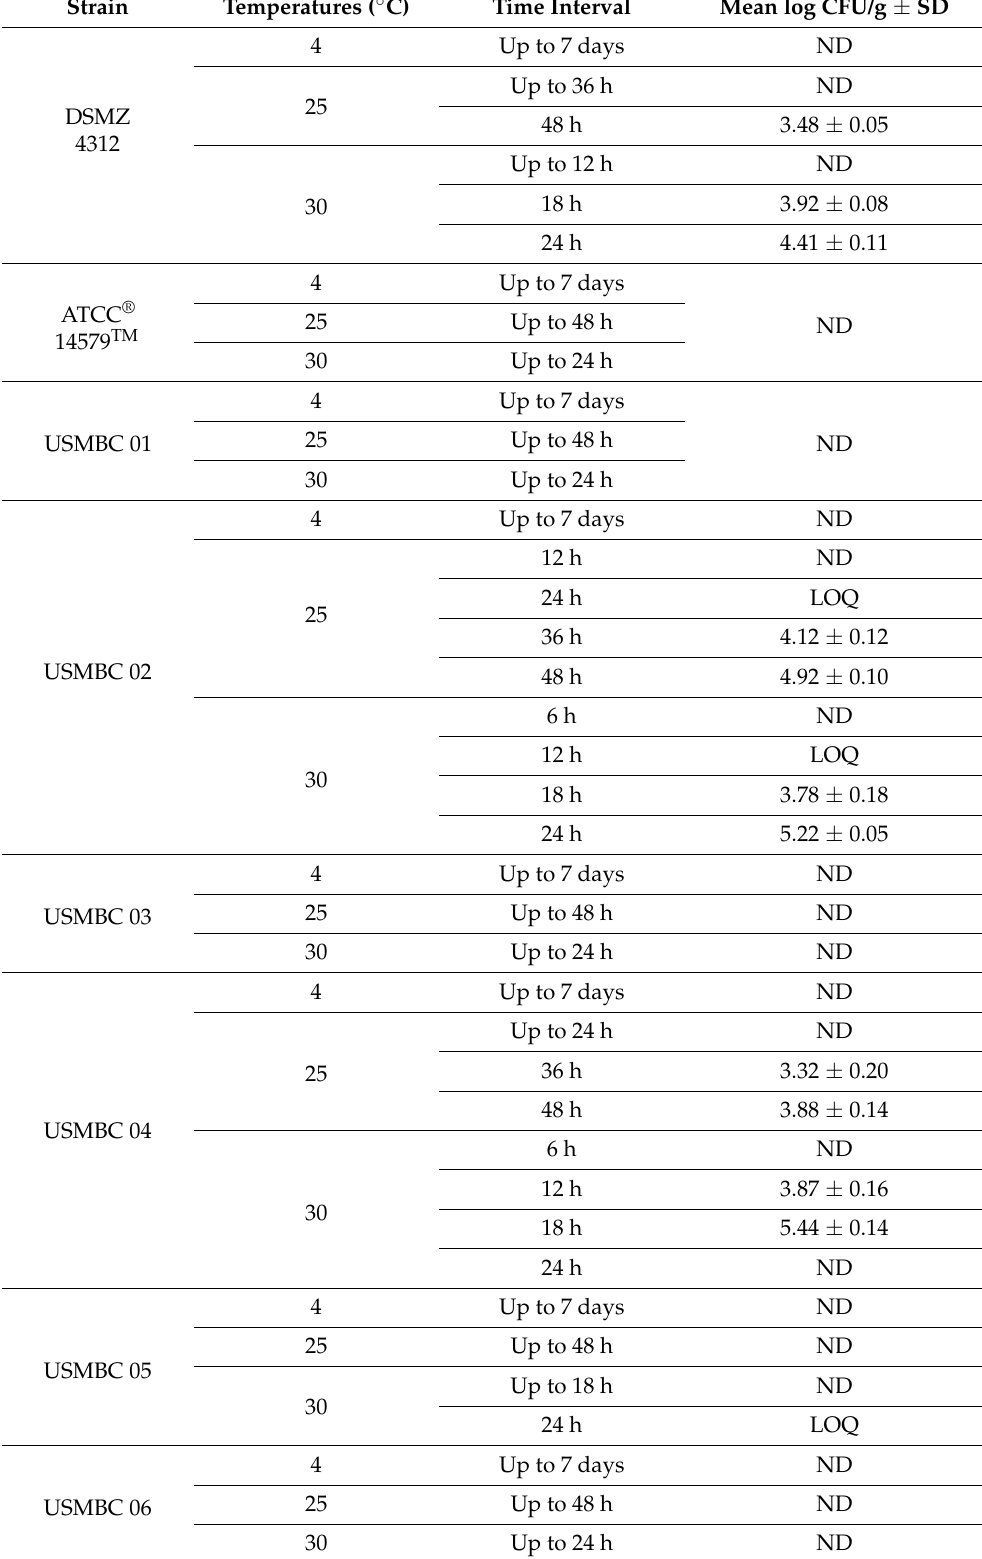
Table 2. The viable counts of B. cereus spores after cooking at different storage temperatures.